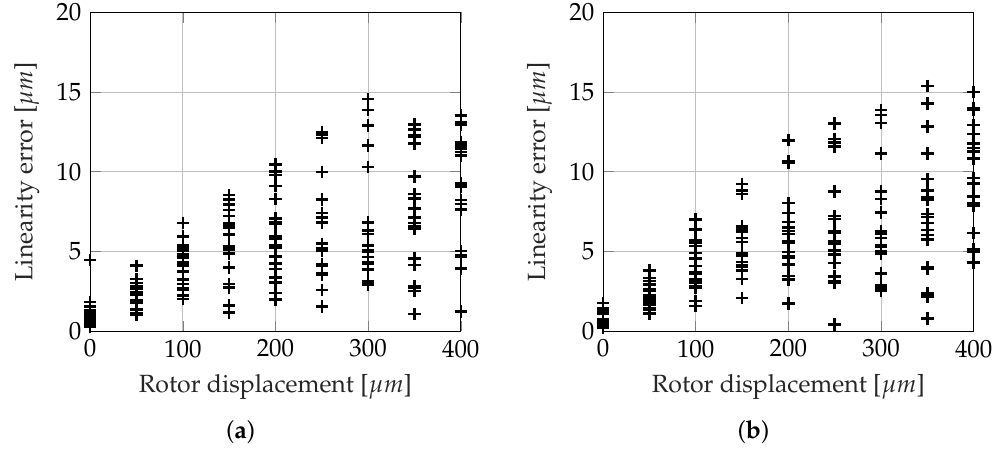
√ e x 2 + e y 2 as a function of the radial rotor